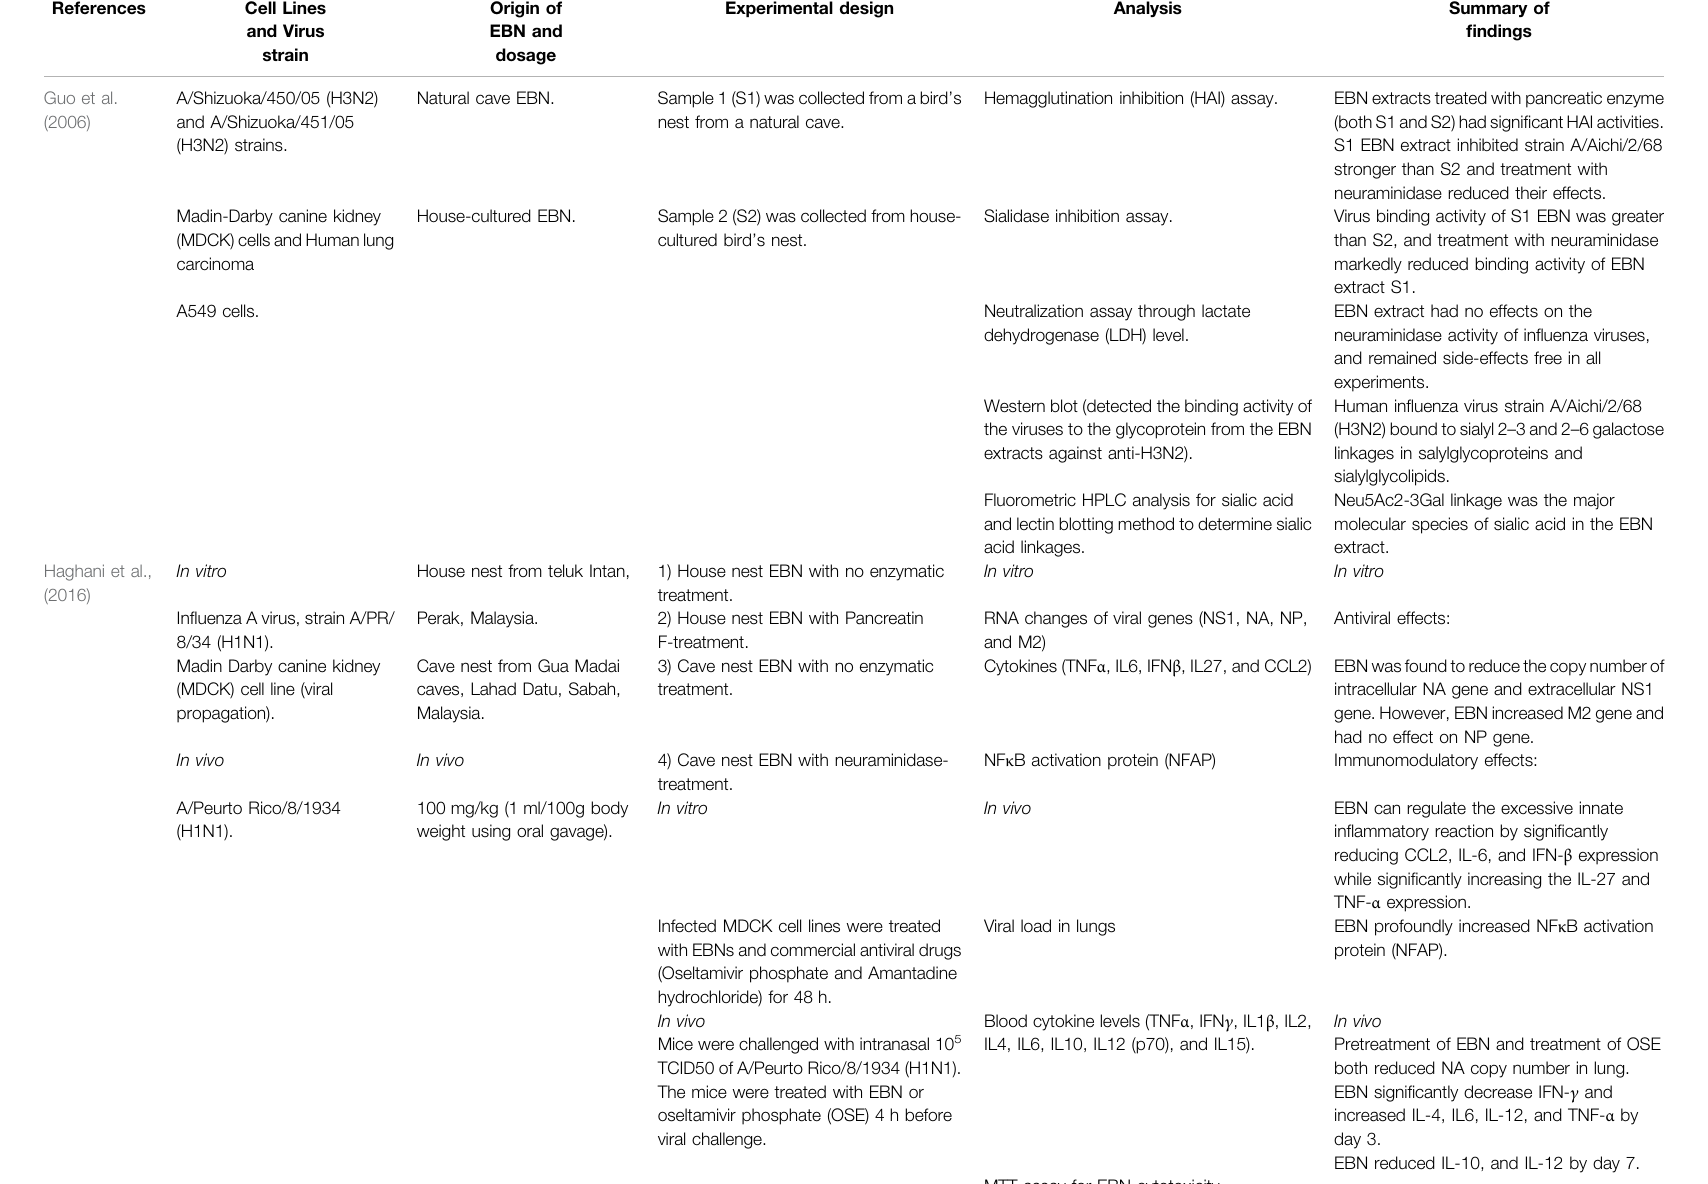
TABLE 3 | Antiviral effects of